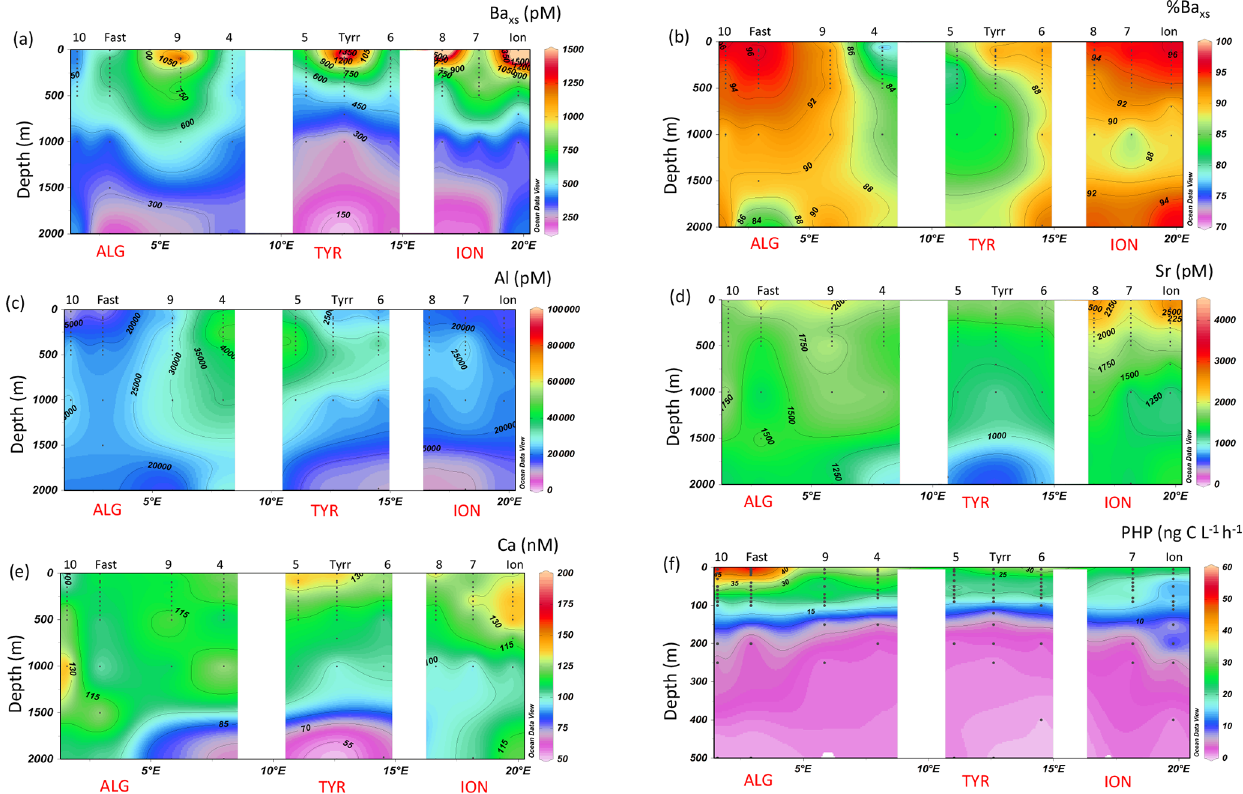
Figure 2. Sections of (a) particulate biogenic Ba (Ba xs , pM), (c) Al (pM), (d) Sr (pM) and (e) Ca (nM) concentrations, and (b) the percentage (%) of biogenic Ba (Ba xs ) in the upper 2000m of the water column. (f) Section of PHP (ngCL − 1 h − 1 ) in the upper 500m of the water column. The figure was produced using Ocean Data View (Schlitzer,